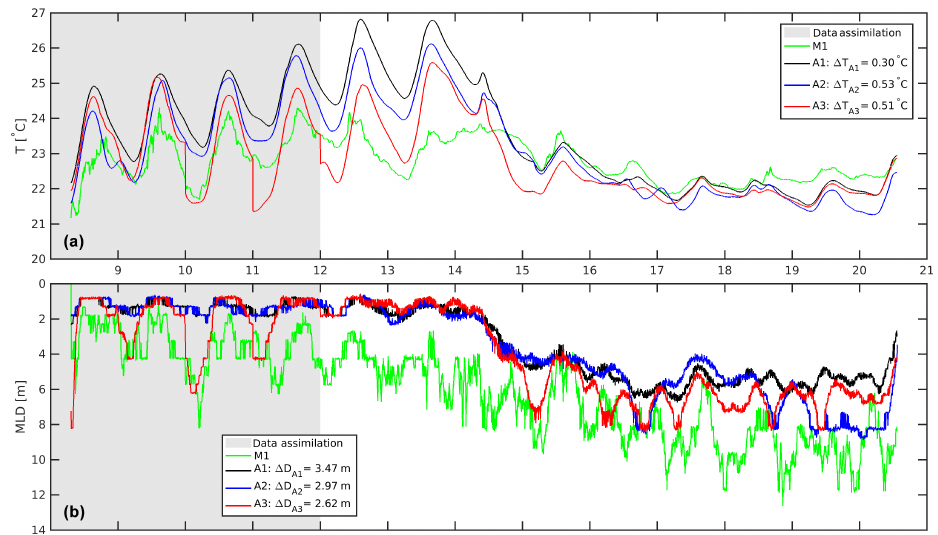
Figure 8. ROMS runs A1, A2, and A3: the time series of the (a) near-surface temperature at 0.81m of depth, (b) the mixed-layer depth (MLD), and the corresponding observations at mooring M1. The numbers on the abscissae indicate June dates. The period for which the data are assimilated is highlighted with grey shading.